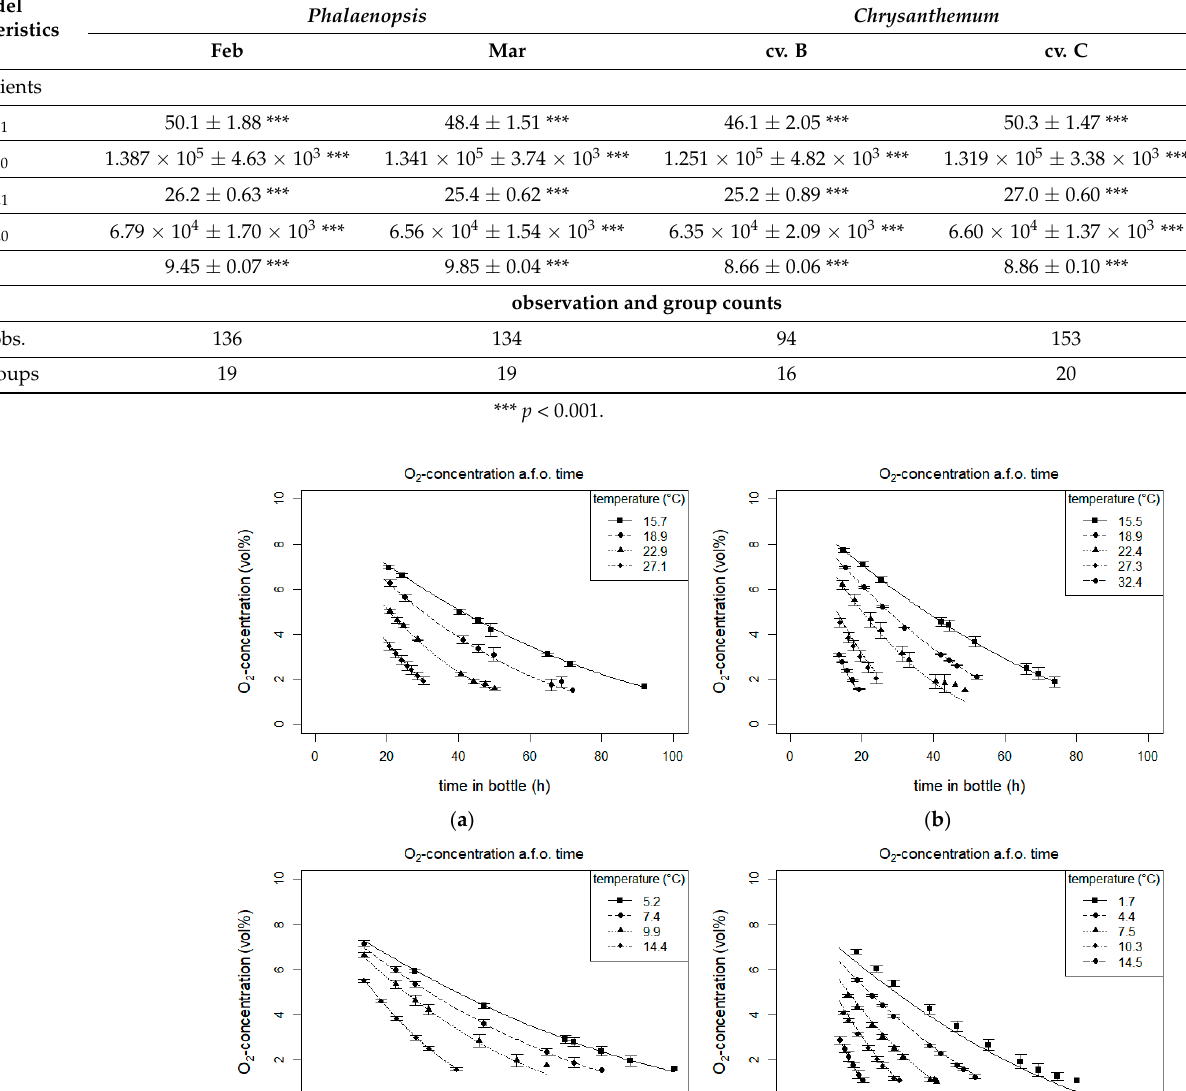
Table 6. Coefficients per set of plant materials for the general fixed-effects model shown as estimate ± SE. Despite March being a replica of the experiment in February, coefficients tend to be different. Model Characteristics